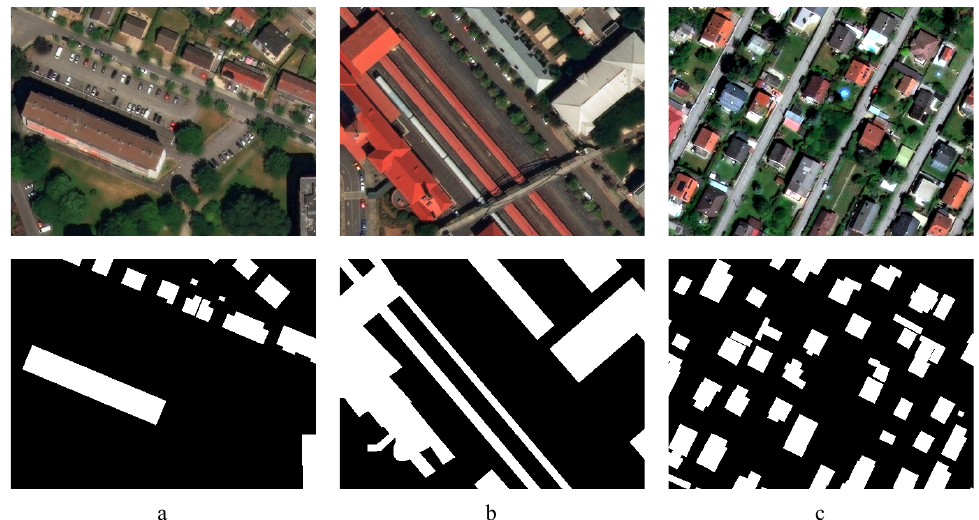
Figure 7. Example patches of areas with different densities: sparse detached structure, SDS ( a ), block structure, BS ( b ), and dense detached structure, DDS ( c ), together with their ground truth (second